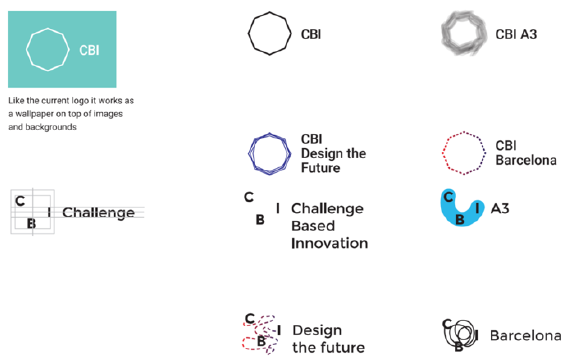
Fig. 8. Two initial proposals for the graphic identity, to decide what path to pursue: a reference to the previous logo or a completely new proposal.